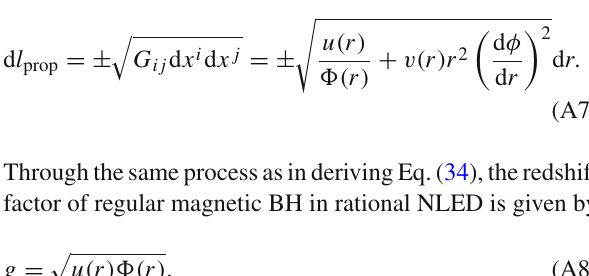
[84], the effective metric of photons takes the form